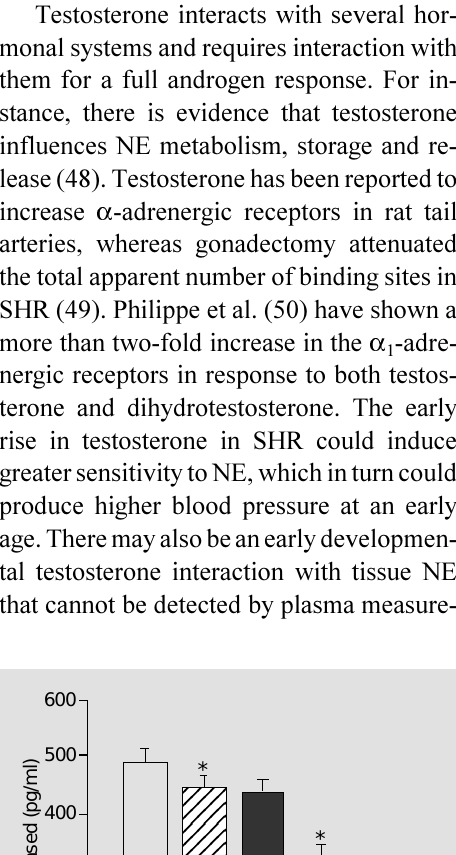
Figure 4 - Y Chromosome and androgen receptor influence on renal norepinephrine (NE) re- lease (pg/ml) from isolated kid- ney by treatment group. Data are reported as means ± SEM. *P<0.05 and **P<0.001 com- pared to SHR/y control.